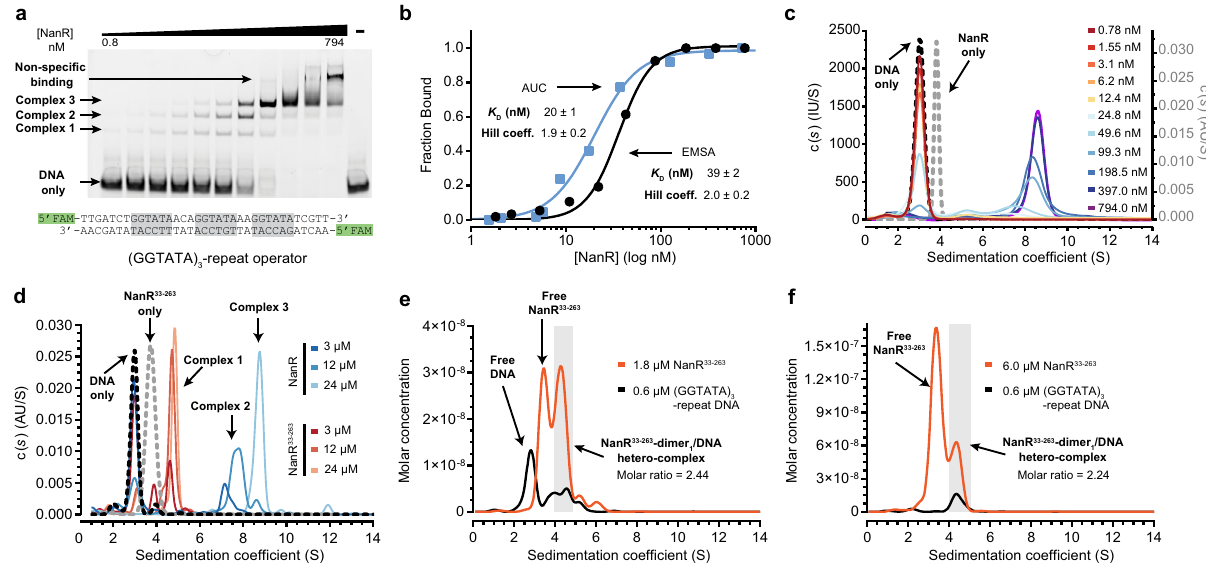
Fig. 2 NanR binds DNA with positive cooperativity and nanomolar af fi nity. a EMSA of NanR titrated against FAM-5 ʹ -labeled (GGTATA) 3 -repeat DNA (10 nM, sequence shown below EMSA). Three concentration-dependent complexes are observed (complexes 1 – 3). Non-speci fi c binding is observed at concentrations of NanR >200 nM. Data presented are representative of at least three independent experiments. b Binding isotherm data from the EMSA (black) and fl uorescence-detected analytical ultracentrifugation (AUC) (blue) data best fi tted the Hill model (AIC value of 99%), as opposed to a non- cooperative binding model (AIC value of 1%). The mean ± SD of the K D and Hill coef fi cient is shown. The independent experiment methods provide complementary data. c Continuous sedimentation coef fi cient [ c ( s )] distributions of NanR (gray dash), FAM-5 ʹ -labeled (GGTATA) 3 -repeat DNA (black dash), and NanR (0.78 – 794 nM; rainbow) titrated against the FAM-5 ʹ -labeled (GGTATA) 3 -repeat (80 nM). The binding isotherm data and fi t are shown in b . The fi tted parameters are shown in Supplementary Table 2. d Continuous sedimentation coef fi cient [ c ( s )] distributions of NanR and NanR 33 – 263 against the FAM-5 ʹ -labeled (GGTATA) 3 -repeat (3 µ M) (blue and orange traces, respectively) and NanR 33 – 263 alone (gray dash). Sedimentation was monitored via the absorbance of the FAM label at 495 nm. All experimental parameters are summarized in Supplementary Table 3. e , f Deconvoluted sedimentation coef fi cient distributions resulting from the titration of NanR 33 – 263 (orange) into (GGTATA) 3 -repeat DNA (0.6 µ M; black): 1.8 µ M NanR 33 – 263 ( e ) and 6.0 µ M NanR 33 – 263 ( f ). A shift in the sedimentation coef fi cient is observed with increasing NanR 33 – 263 concentration, consistent with hetero-complex formation. The molar ratio of the integrated peaks (shaded in gray) is that of a dimer. The presence of excess protein free of any co-migrating DNA in ( f ) indicates that hetero-complex formation has reached saturation. All plots are presented as g ( s ) distributions with the molar concentration for each interacting partner (protein and DNA) plotted on the y -axis. Hydrodynamic parameters are in Supplementary Table